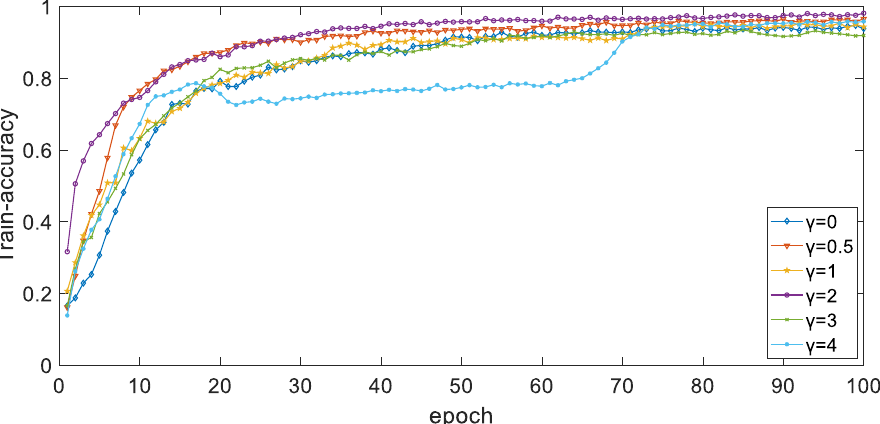
Figure 8. The F1-score comparison of HAR-CE and HAR-FL in each class.